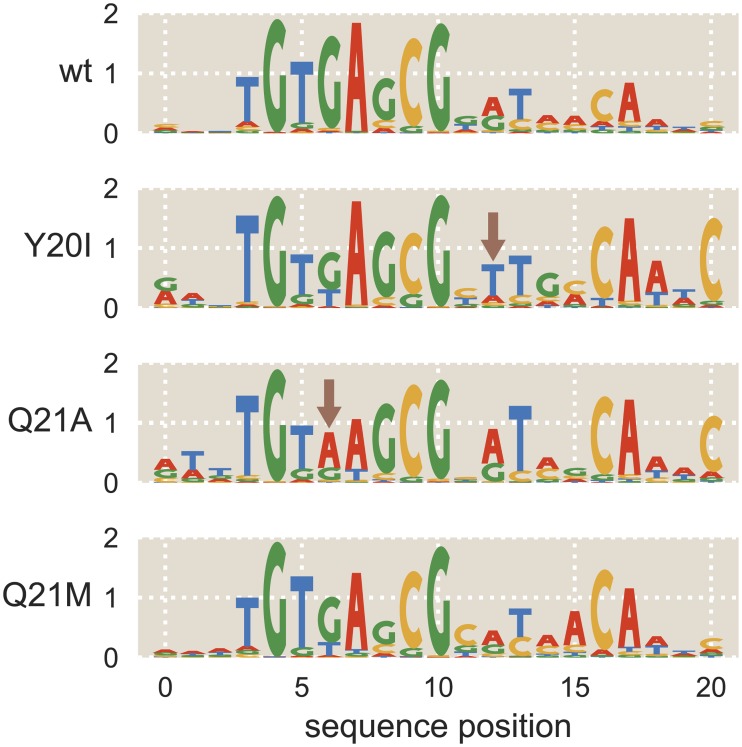
Mutations to LacI DNA-binding domain cause subtle changes to sequence specificity.Mutations were made to residues 20 and 21 of LacI, both of which lie within the DNA-binding domain. The mutations Y20I and Q21A weaken the repressor-operator binding energy, while the mutation Q21M strengthens the binding energy [50]. The sequence preferences of each mutant are represented as sequence logos. Y20I exhibits minor changes to specificity in low-information regions of the binding site, and Q21A experiences a change to specificity within a high-information region of the binding site (see arrows). Specifically, Q21A prefers A at operator position 6 while the wild-type repressor prefers G at this position.